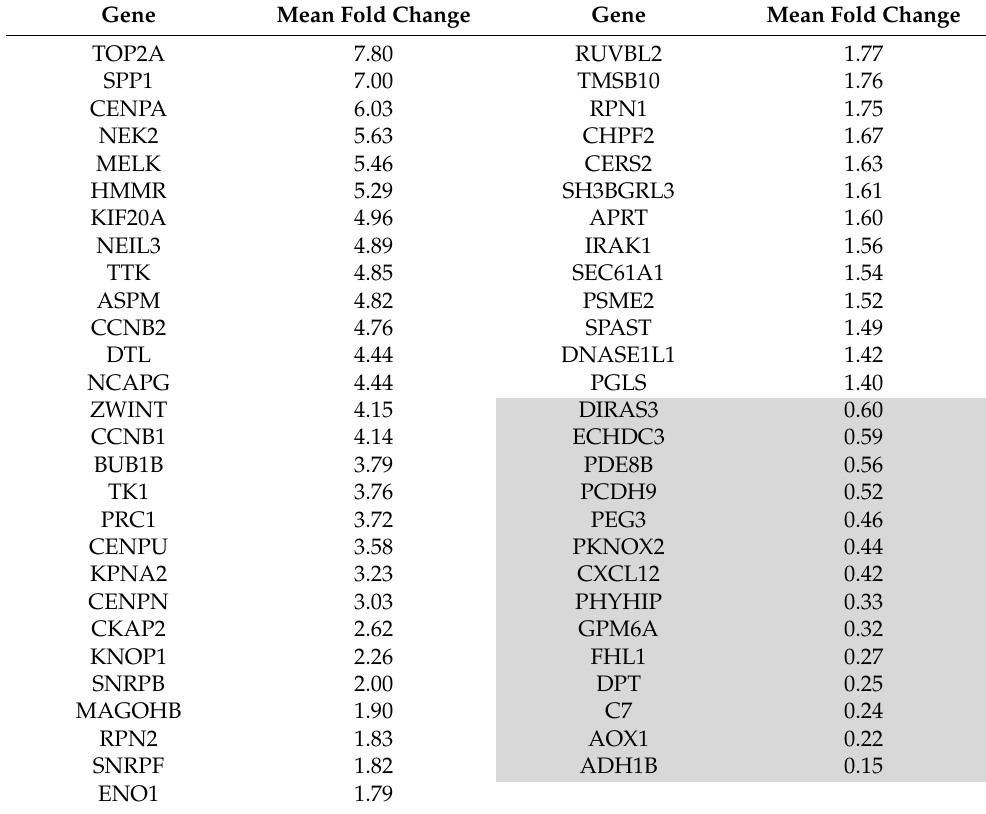
Table 2. Top fifty-five genes differentially expressed when comparing normal and tumor samples across the ten most common tumor types in RNA-seq and gene array datasets. Fold change over one corresponds to higher expression in tumors, and fold change below one corresponds to higher expression in normal specimens (highlighted in